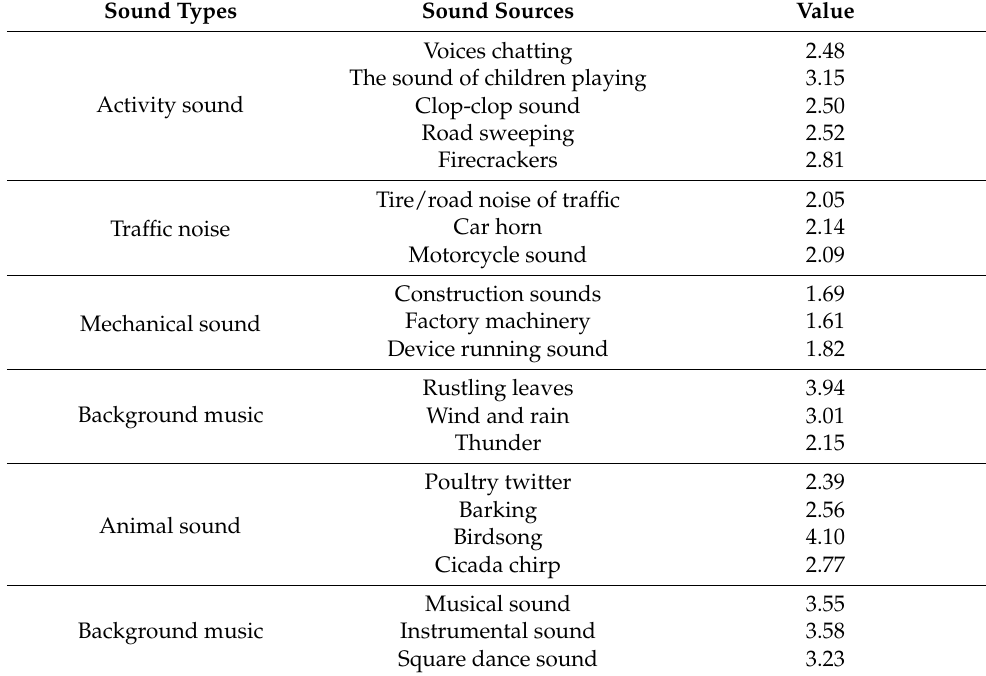
Table 4. Evaluation of outdoor sound preferences.